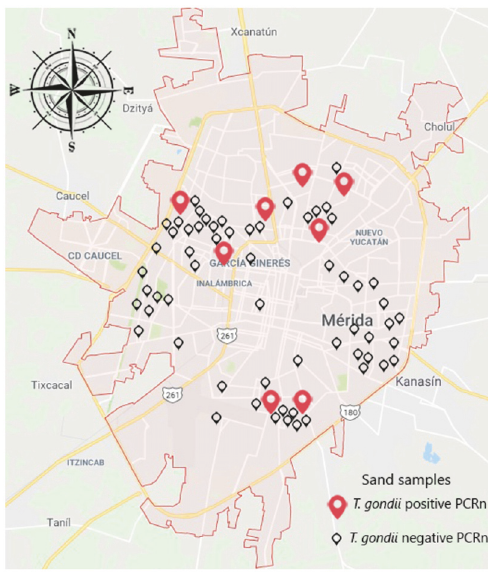
Figure 1: Distribution of sampled points of sand from sandbox playgrounds in the city of Merida, Yucatan, Mexico, where positive cases for T. gondii DNA were found through nested PCR.